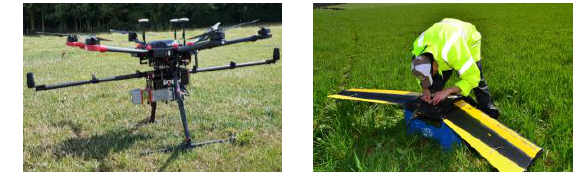
Figure 2: Examples of rotary-wing (left: DJI Matrice 600 LiDAR; Davidson et al. (2019)) and fixed-wing (right: QPOD; Berra et al. (2019))